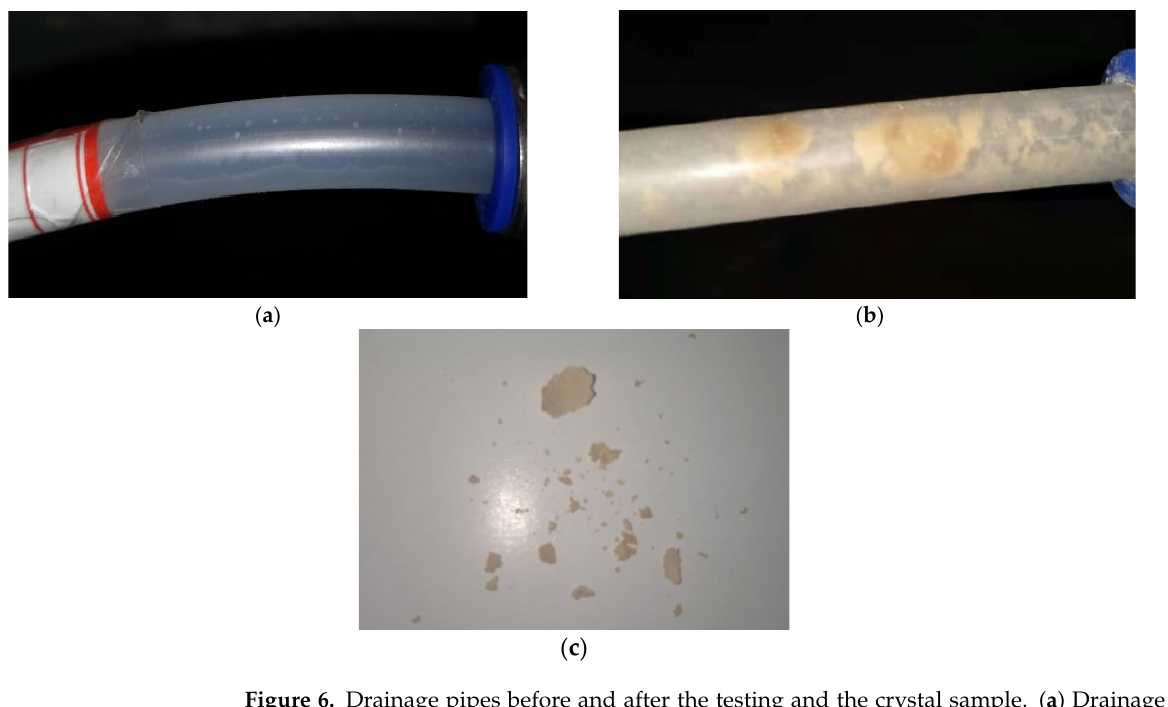
Figure 6. Drainage pipes before and after the testing and the crystal sample. ( a ) Drainage pipes before the testing. ( b ) Drainage pipes after the testing. ( c ) The crystal sample.